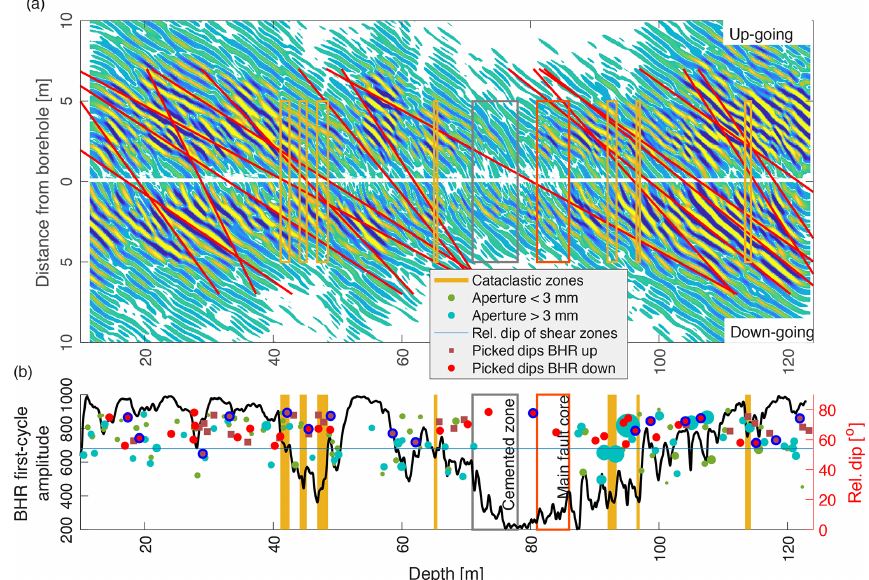
Figure 3. (a) Migrated BHR image consisting of the up- and down-going reflection data plotted in positive distance from the borehole trajectory. Red lines denote selected reflection events used for estimating the dips and locations of the associated fractures. (b) Maximum first-cycle amplitude of BHR first arrivals (black line), relative dip of fractures from OTV data (turquoise dots), and relative dips picked from the depth-converted BHR reflection image (red dots and squares). For the OTV data, the size of the dots is a relative measure of fracture aperture. The dips of events denoted by red lines in (a) are identified by red dots encircled in